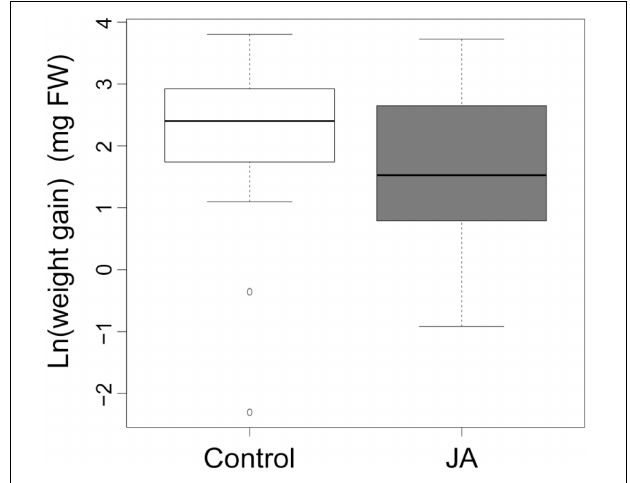
FIGURE 1 | Larval weight gain. The average weight gain of Spodoptera littoralis caterpillars feeding on plants that received jasmonic acid (JA) in the roots 4 days prior to the start of herbivory or received no JA in the roots (Control). Weight gain was calculated as the natural logarithm of the difference between final and initial fresh weight. The two boxplots are significantly different (ANOVA, p < 0.05).